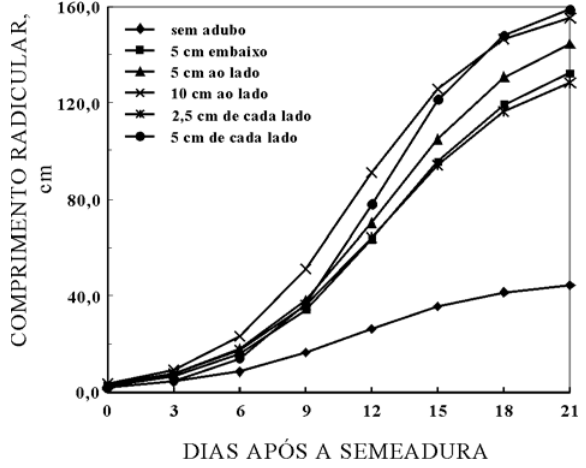
Figura 1. Comprimento radicular do algodoeiro de acordo com a localização do adubo em relação às